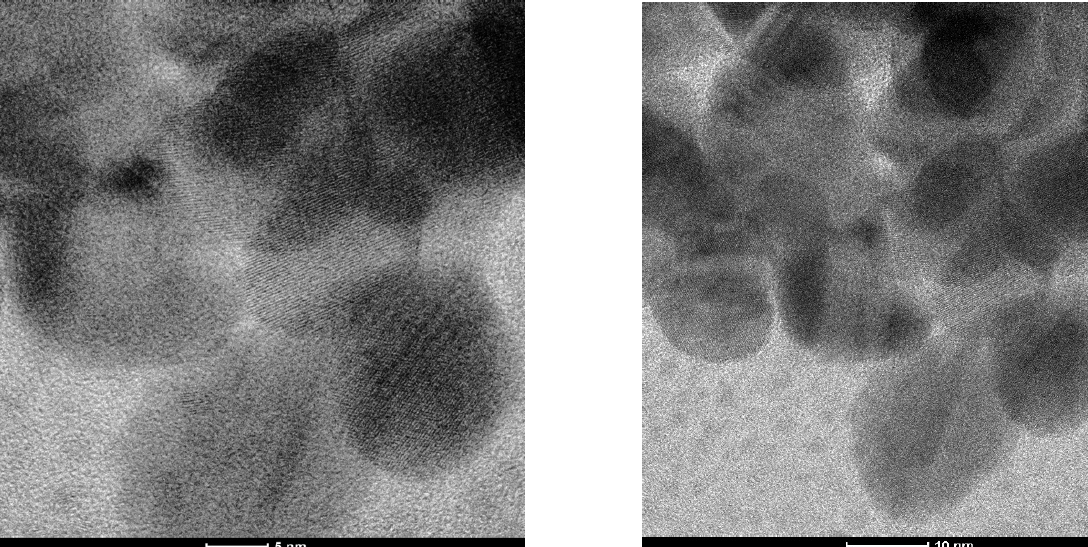
Nanomaterials 2022 , 12 , x FOR PEER REVIEW Figure 5. TEM image of Fe 3 O 4 @Chitosan-AgNPs (0.2). Figure 5. TEM image of Fe 3 O 4 @Chitosan-AgNPs (0.2).